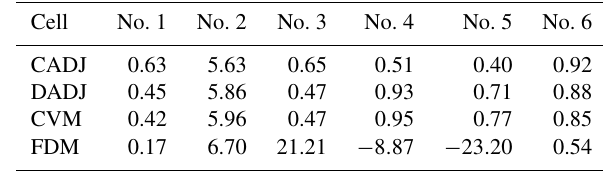
Table 1. Evaluation of the full adjoint model with the CADJ (con- tinuous adjoint) and DADJ (discrete adjoint) against the CVM (complex variable method) and FDM(finite-difference method) sen- sitivities of the concentrations of an accumulation-mode aerosol species ASO4J (µgm − 3 ) at hour 24 with respect to the concentra- tions of a gas species SO 2 (ppmV) at hour 23. The cells are arbi- trarily picked. The perturbation size for the CVM is 1.E-12 and the one for the FDM 10%. The relation of FDM and CVM sensitivities with CADJ and DADJ results has been discussed in Sect.